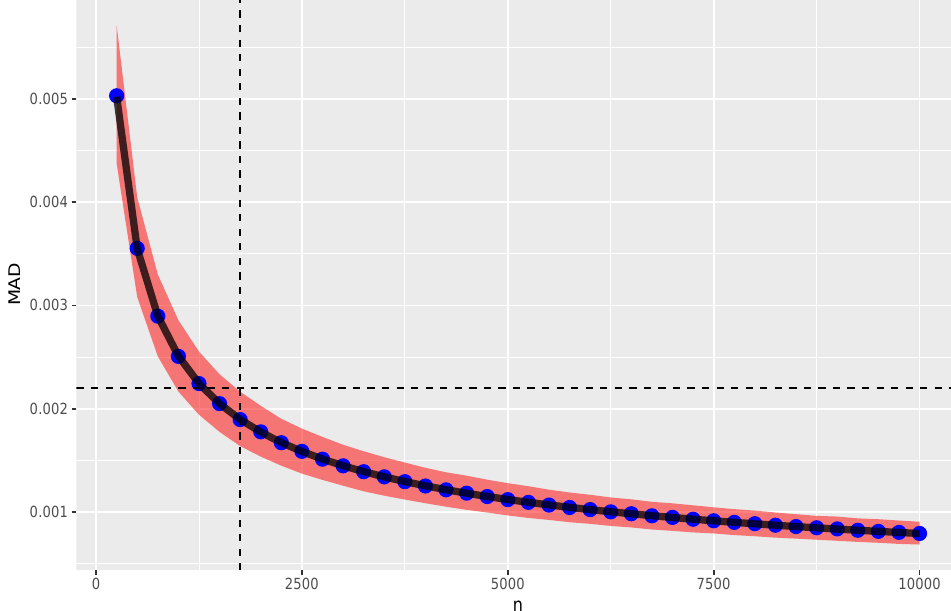
Figure 11. Average estimated MAD s over 1000 replications under the (Benford’s law) null hypothesis √ n (black curve) for varying sample sizes n ∈ ( 250,500, . . . ,10,000 ) . α is a scale (blue points) and α / √ n on the same scale as MAD . The shaded area represents the central 90% of factor used to report 1/ the distribution of estimated MAD s. The horizontal dashed line corresponds to Nigrini’s suggested critical value (0.0022). The vertical dashed line corresponds to n =